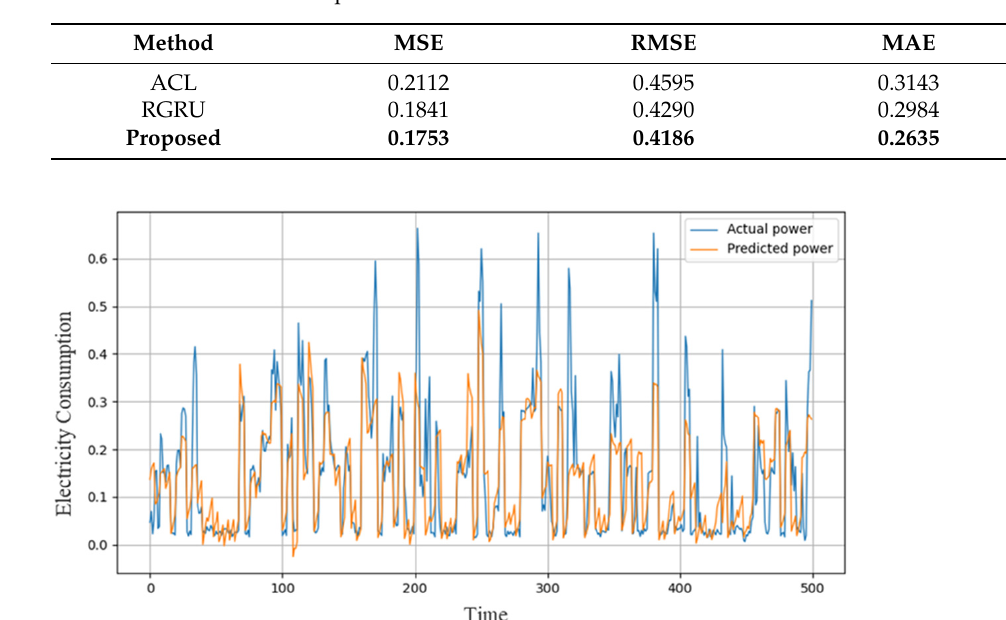
Table 3. Various models performance over the IHEPC dataset using hourly resolution data. Bolds results demonstrate the best performance.